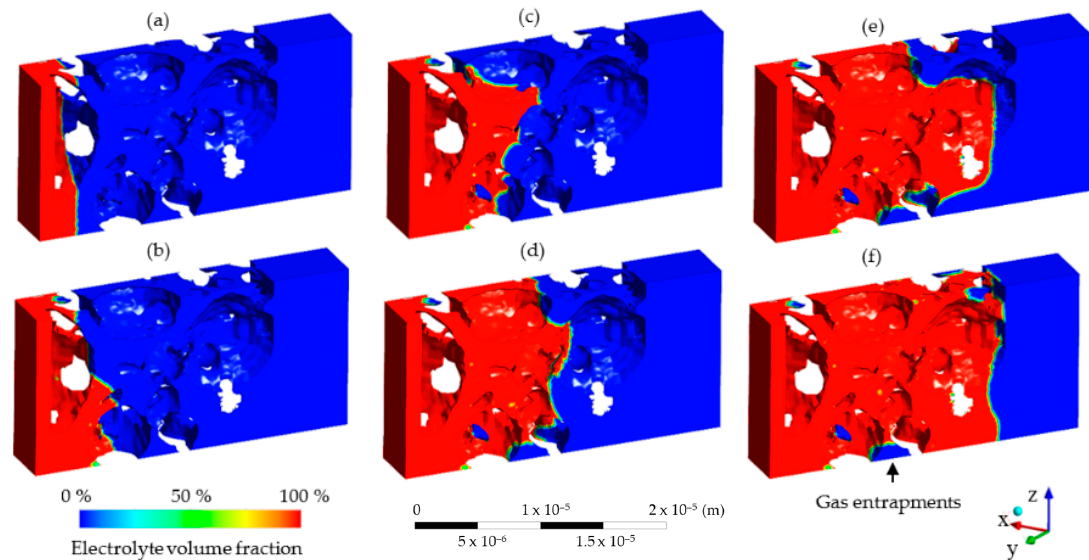
Figure 7. Micro simulation results of the electrolyte flow during the wetting of the cell during time steps ( a ) 0.0 s, ( b ) 3.9 x 10 -5 s, ( c ) 2.5 x 10 -5 s, ( d ) 1.0 x 10 -5 s, ( e ) 1.6 x 10 -5 s and ( f ) 2.5 x 10 -5 s of filling time. Each section represents a small section (3 x 10 -5 m, or 30 µm) of the battery electrode. Fluid starts on the left side of the cell and slowly enters the gas-filled pores. Process parameters such as pressure and temperature are neglected, and the fluid moves purely due to the capillary forces acting on the porous media.